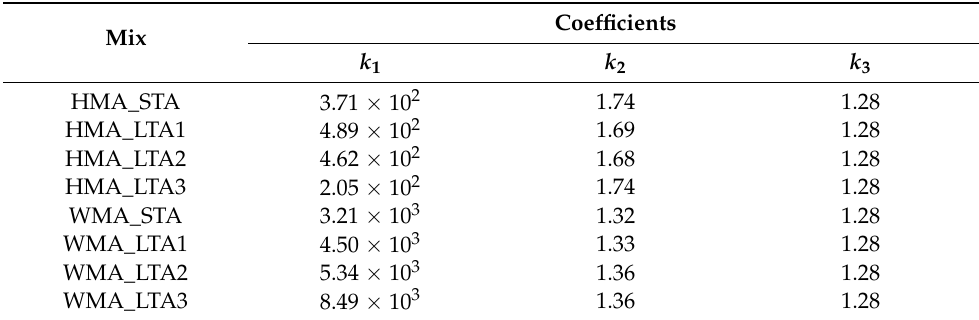
Table 6. Fatigue cracking prediction model coefficient of the HMA and WMA mixture for different stages of